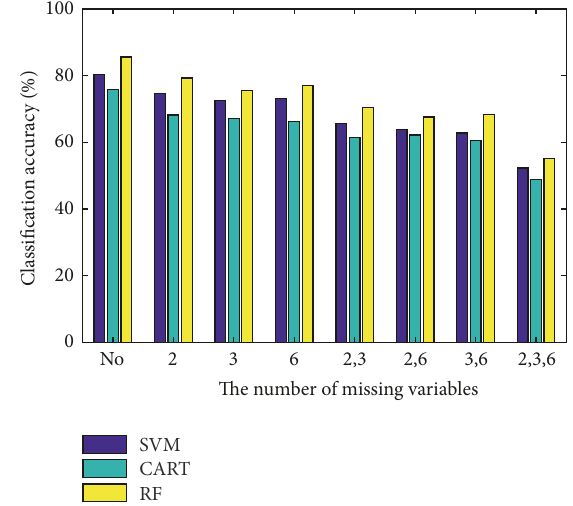
Figure 8: The classification accuracy of the three methods in the absence of